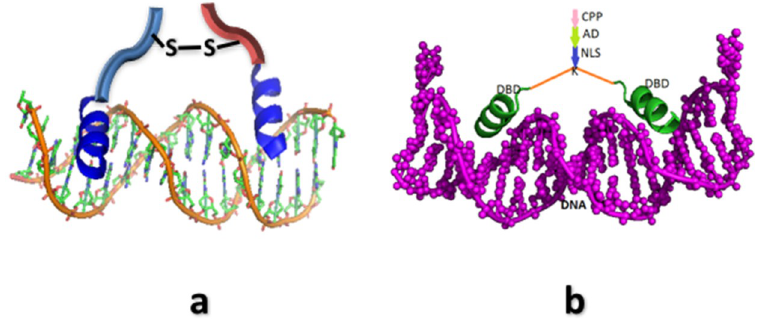
Figure 2. Cartoon diagram of structure of ( a ) Synthetic Transcription Factor (STF) mimicking the λ -Cro; Bright blue part is the helical part of the construct, while the linker regions are represented in light blue and red colours. ( b ) STF mimicking the λ -Cro but carrying mammalian NLS, CPP, and Activation Domain (AD). Orange chain denotes the linker.